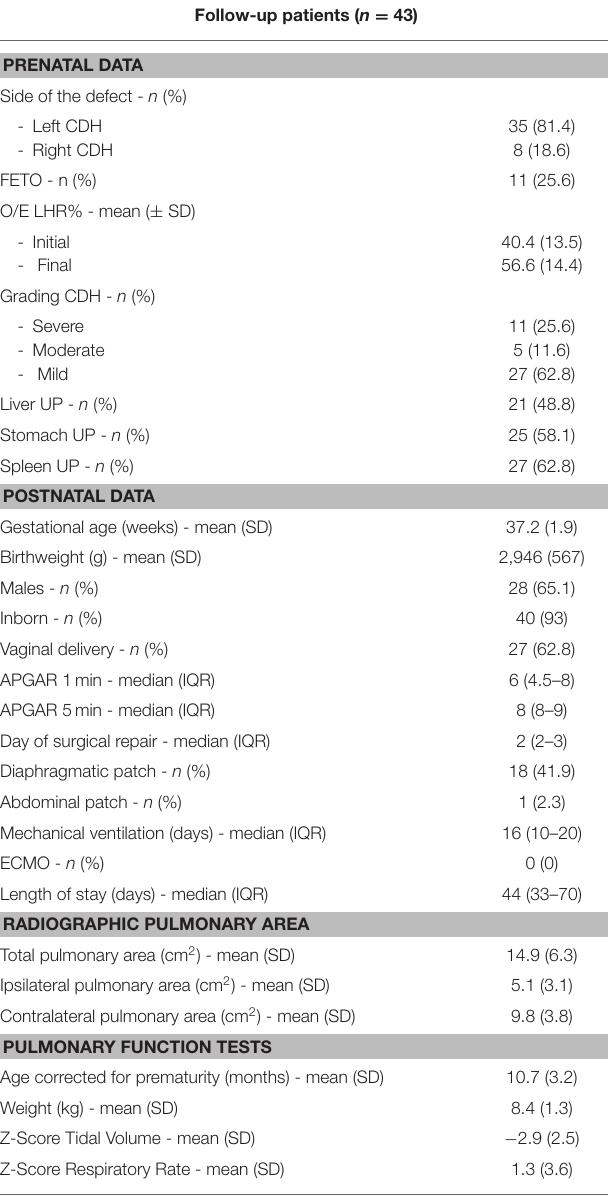
TABLE 1 | Characteristics of the follow-up population. Follow-up patients ( n =